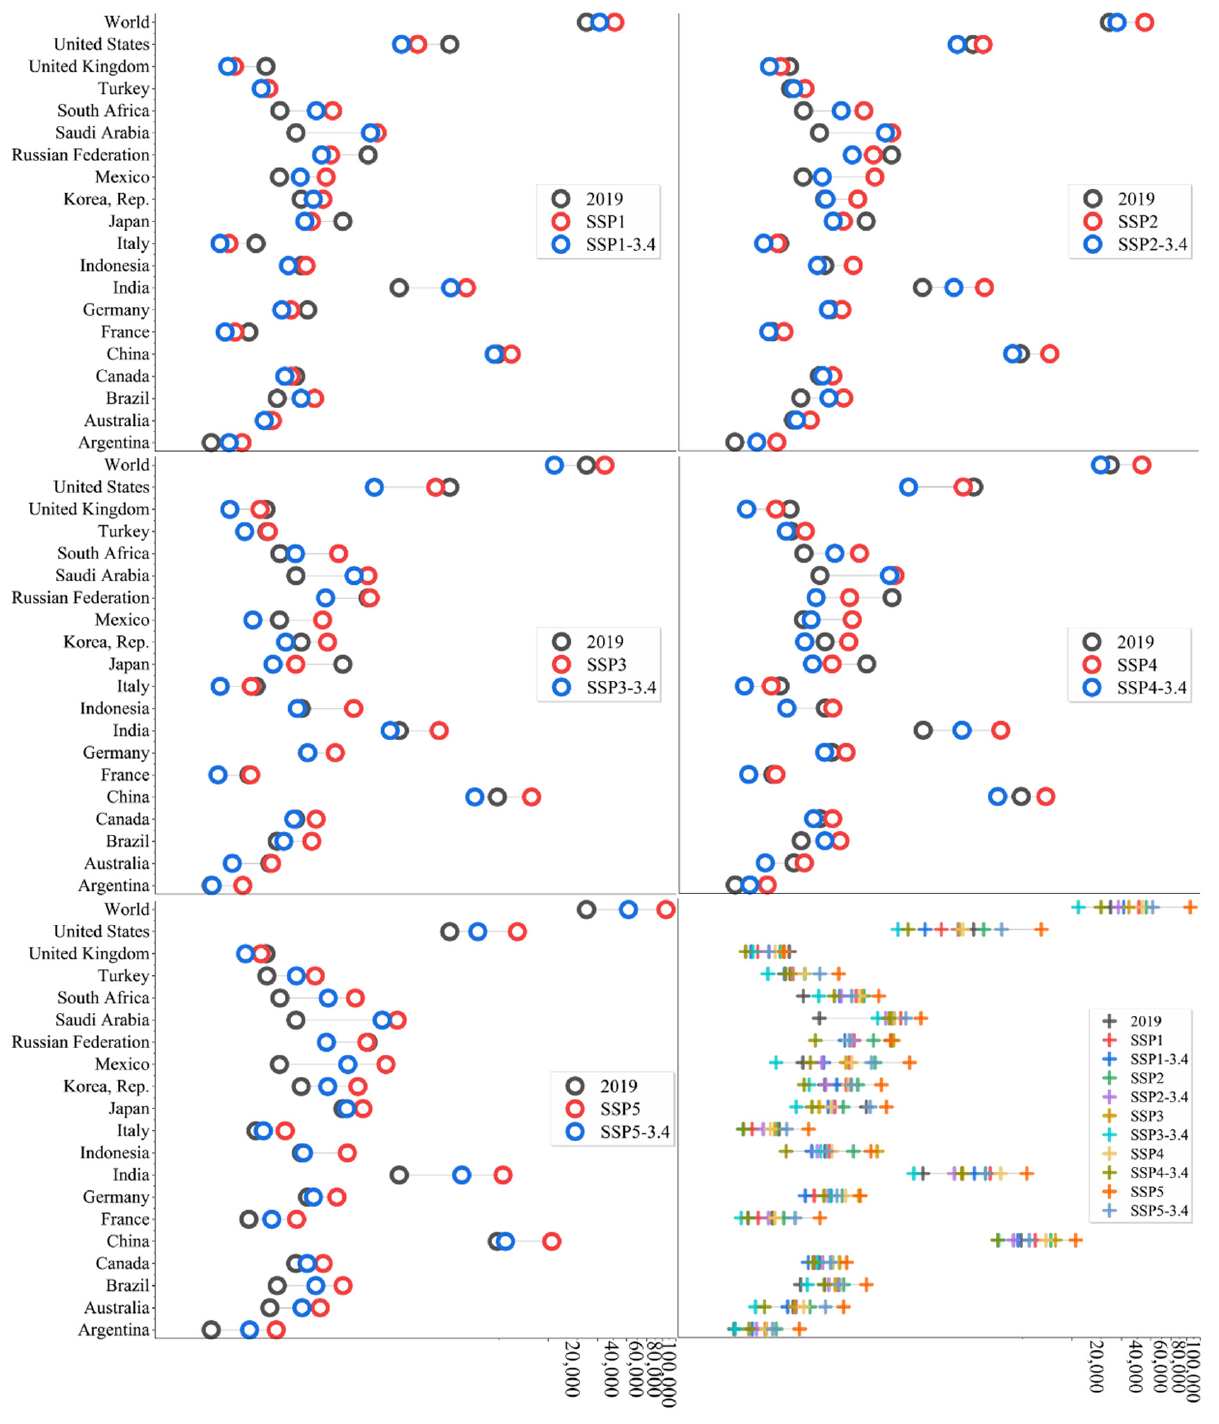
Figure 4. CO 2 emissions in 2050 compared to 2019.